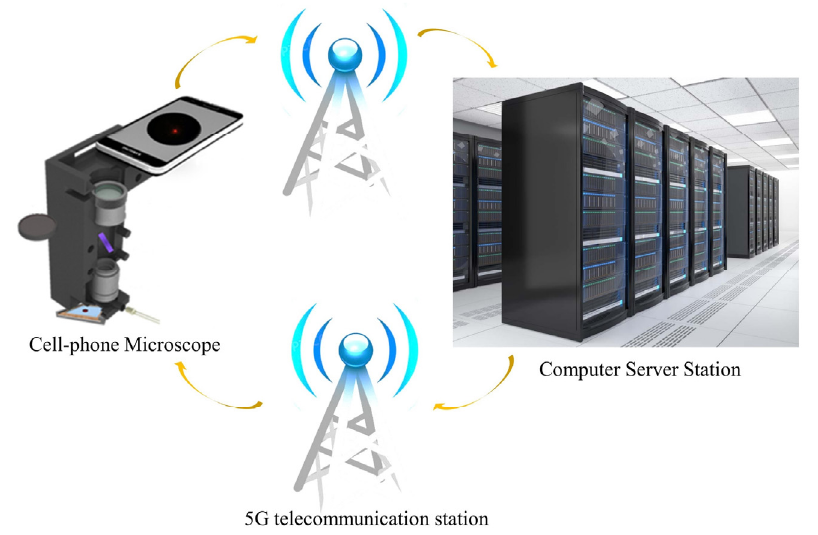
Figure 6. Interaction pipeline maps of cell-phone microscopes, 5G telecommunication stations and computer sever stations.